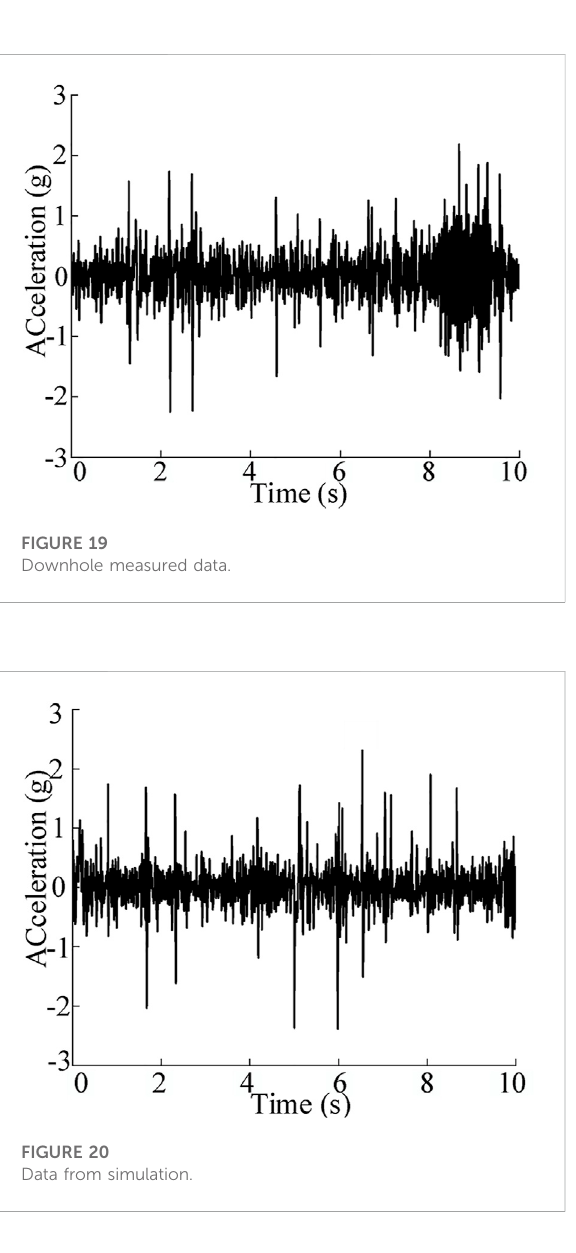
Figure 20. The vibration characteristic values are shown in Table 6. From the 19 diagrams, Figure 20, and Table 6, it can